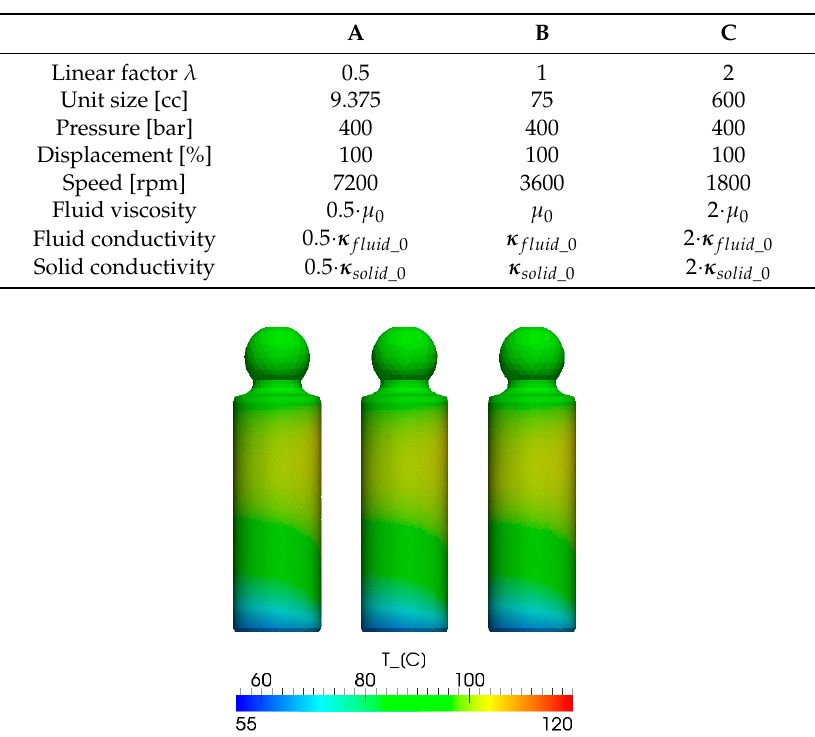
Table 3. Summary of operating conditions with scaled fluid viscosity.